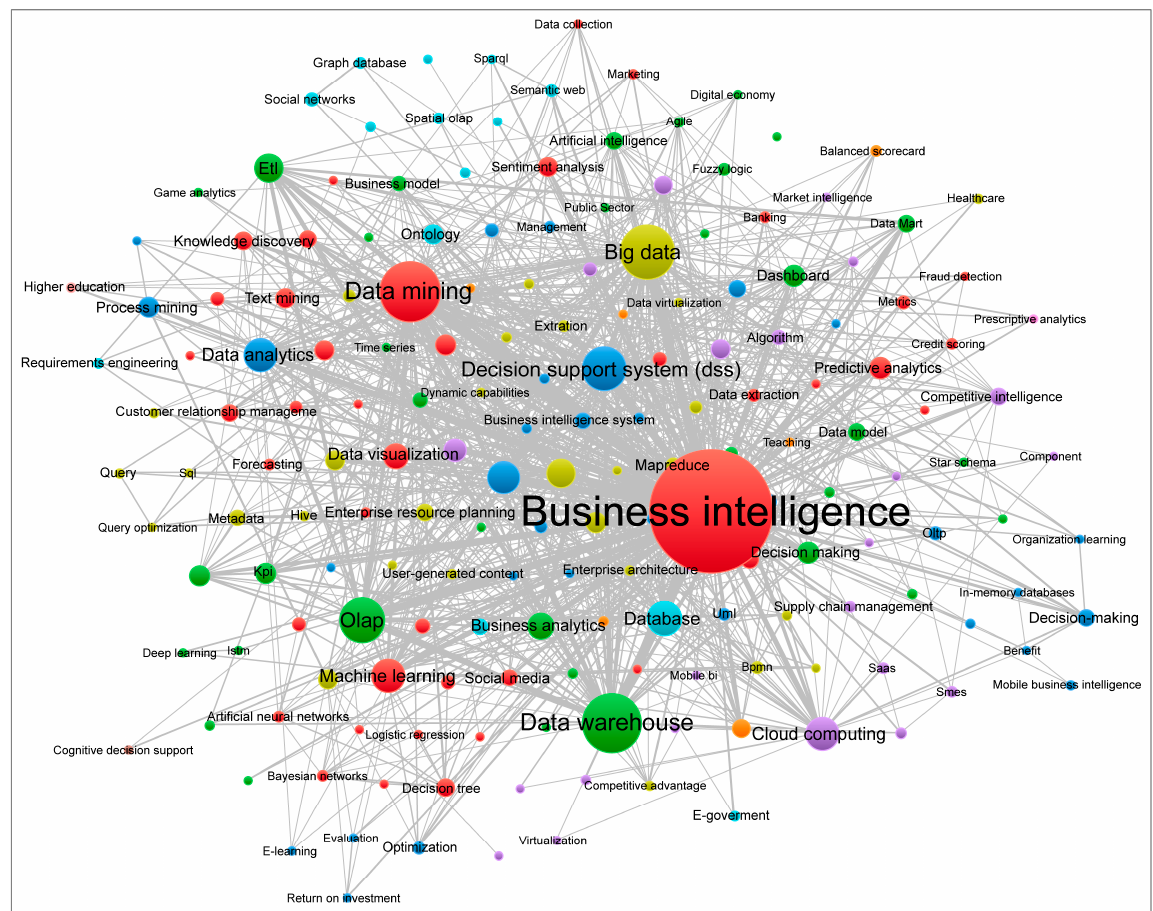
Figure 14. Network visualization map.